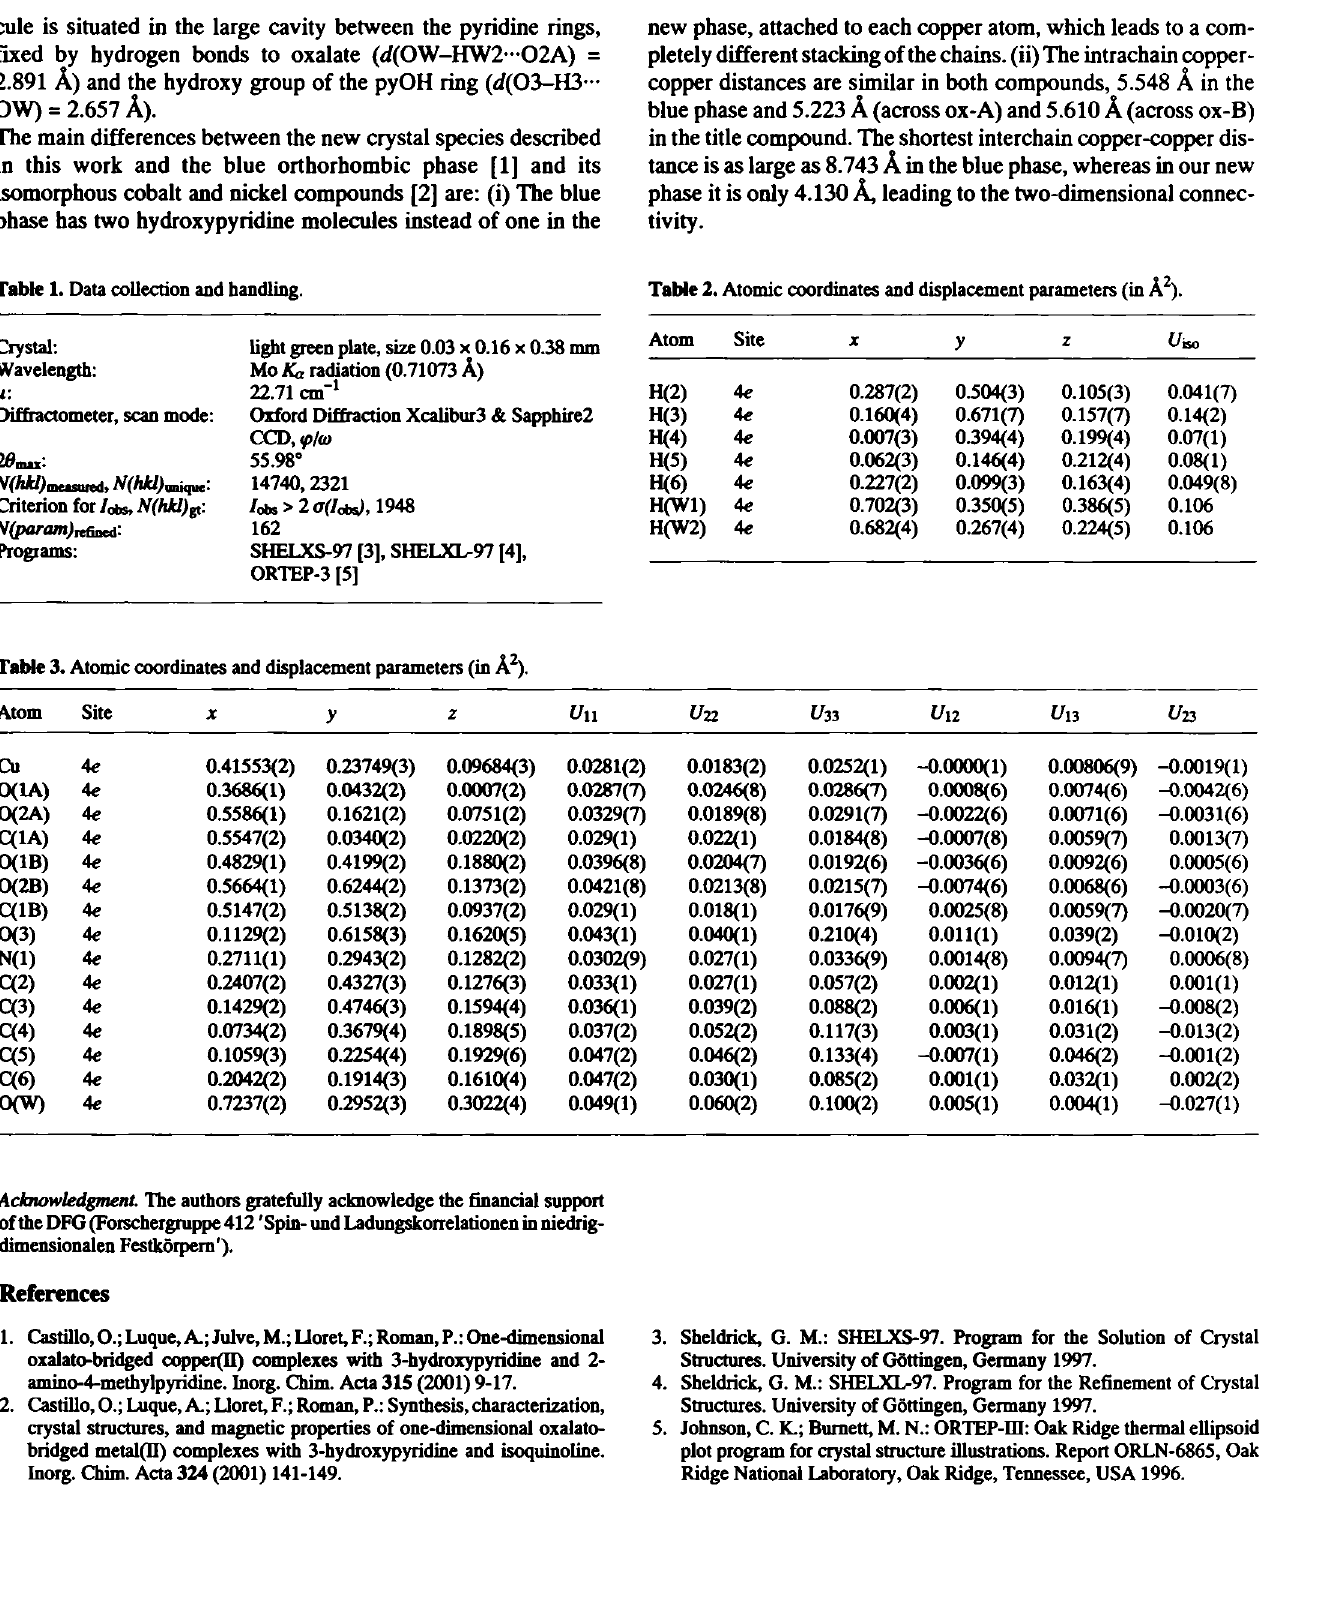
Tabic 1. Data collection and handling. Table 2. Atomic coordinates and displacement parameters (in Ä 2 ).